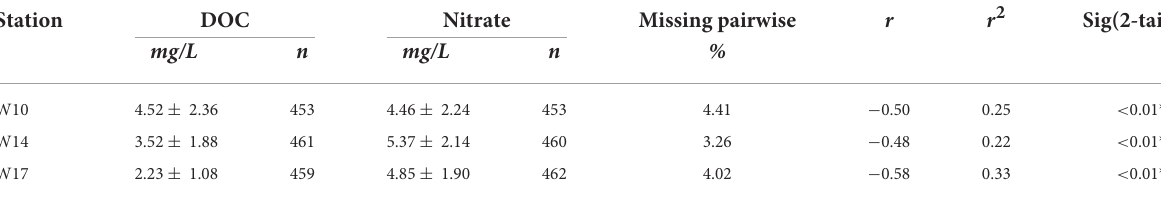
TABLE 2 Mean DOC and nitrate concentrations of the Wüstebach and reference streams and their linear relationships.